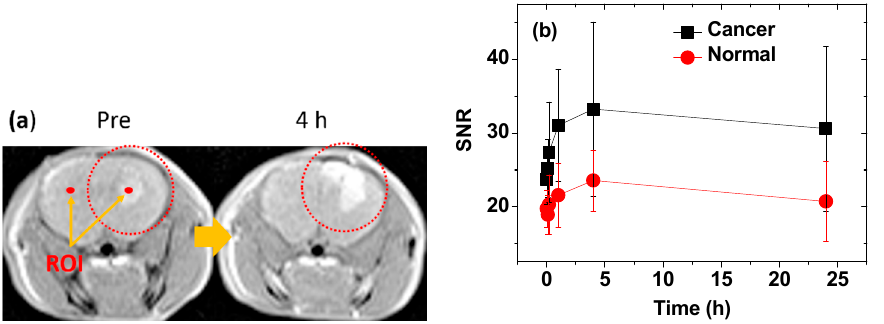
Figure 9. ( a ) T 1 magnetic resonance (MR) images before (pre = 0 h) and 4 h after intravenous administration. The dotted circles indicate the location of the brain cancer. Region-of-interest (ROI) at the brain cancer site and normal brain tissue (labeled with small dots and arrows). ( b ) Plots of SNR ‒ ROI versus time, where SNR is the signal-to-noise ratio.